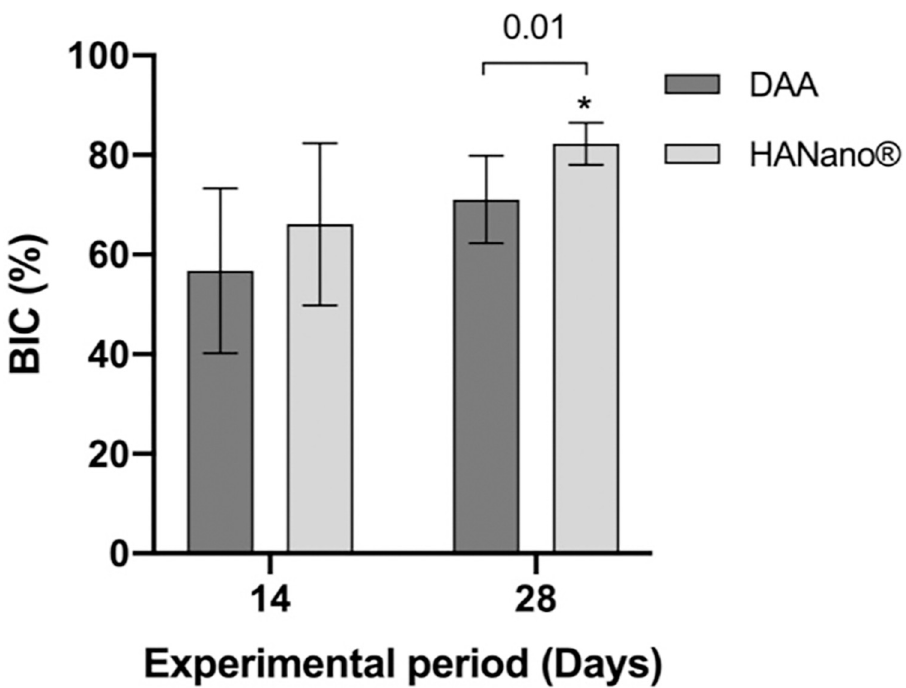
Fig 7. Histomorphometric BIC (%) results as a function of the DAA and HAnano surfaces and 14- and 28-day experimental periods. BIC values are presented as the mean with 95% CI across five samples. Key: � , p = 0.02.